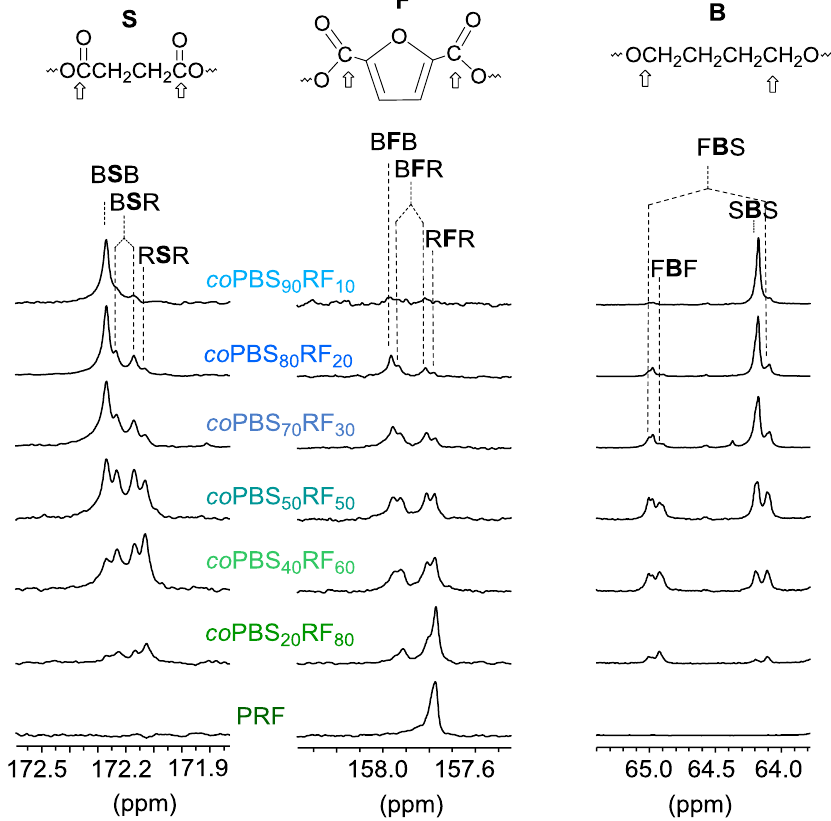
Figure 7. Aromatic and aliphatic carbonyl carbons regions of the 13 C NMR spectra of co PBS x RF y copolyesters used for calculation of their microstructure .